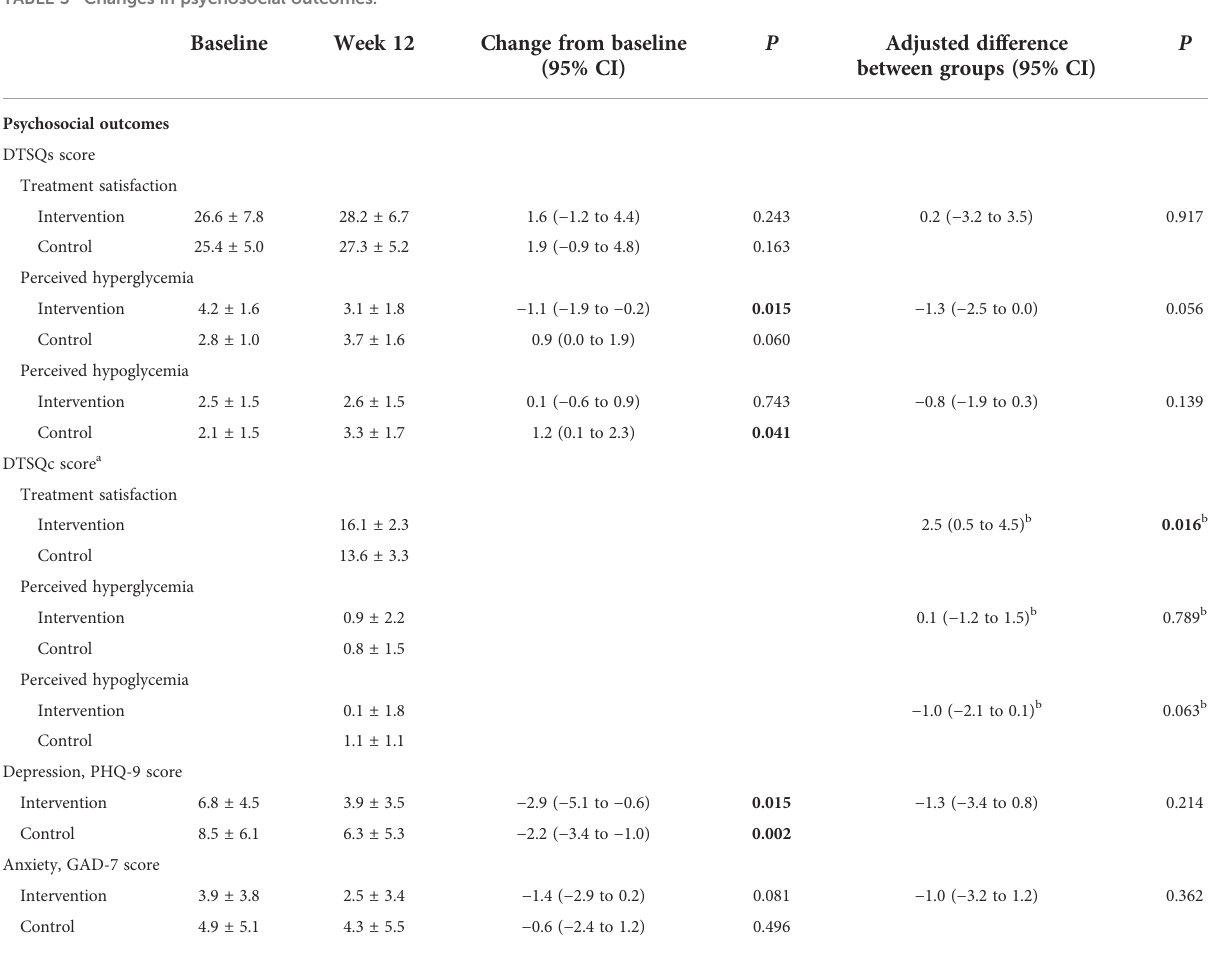
TABLE 3 Changes in psychosocial